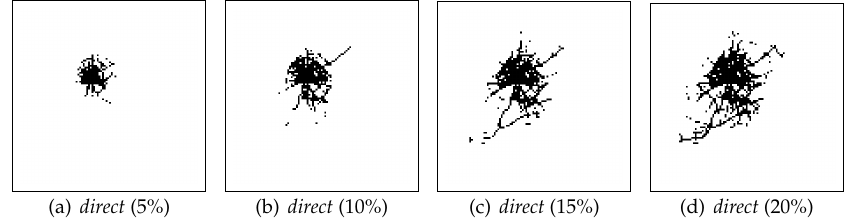
Figure 9. ( a – d ) Show the layout of roadside units deployed by direct for covering 5%, 10%, 15%, and 20% (respectively) of the road network. We notice that direct presents a denser distribution of roadside units around the epicenter of traffic when compared to strategy balanced (Figure